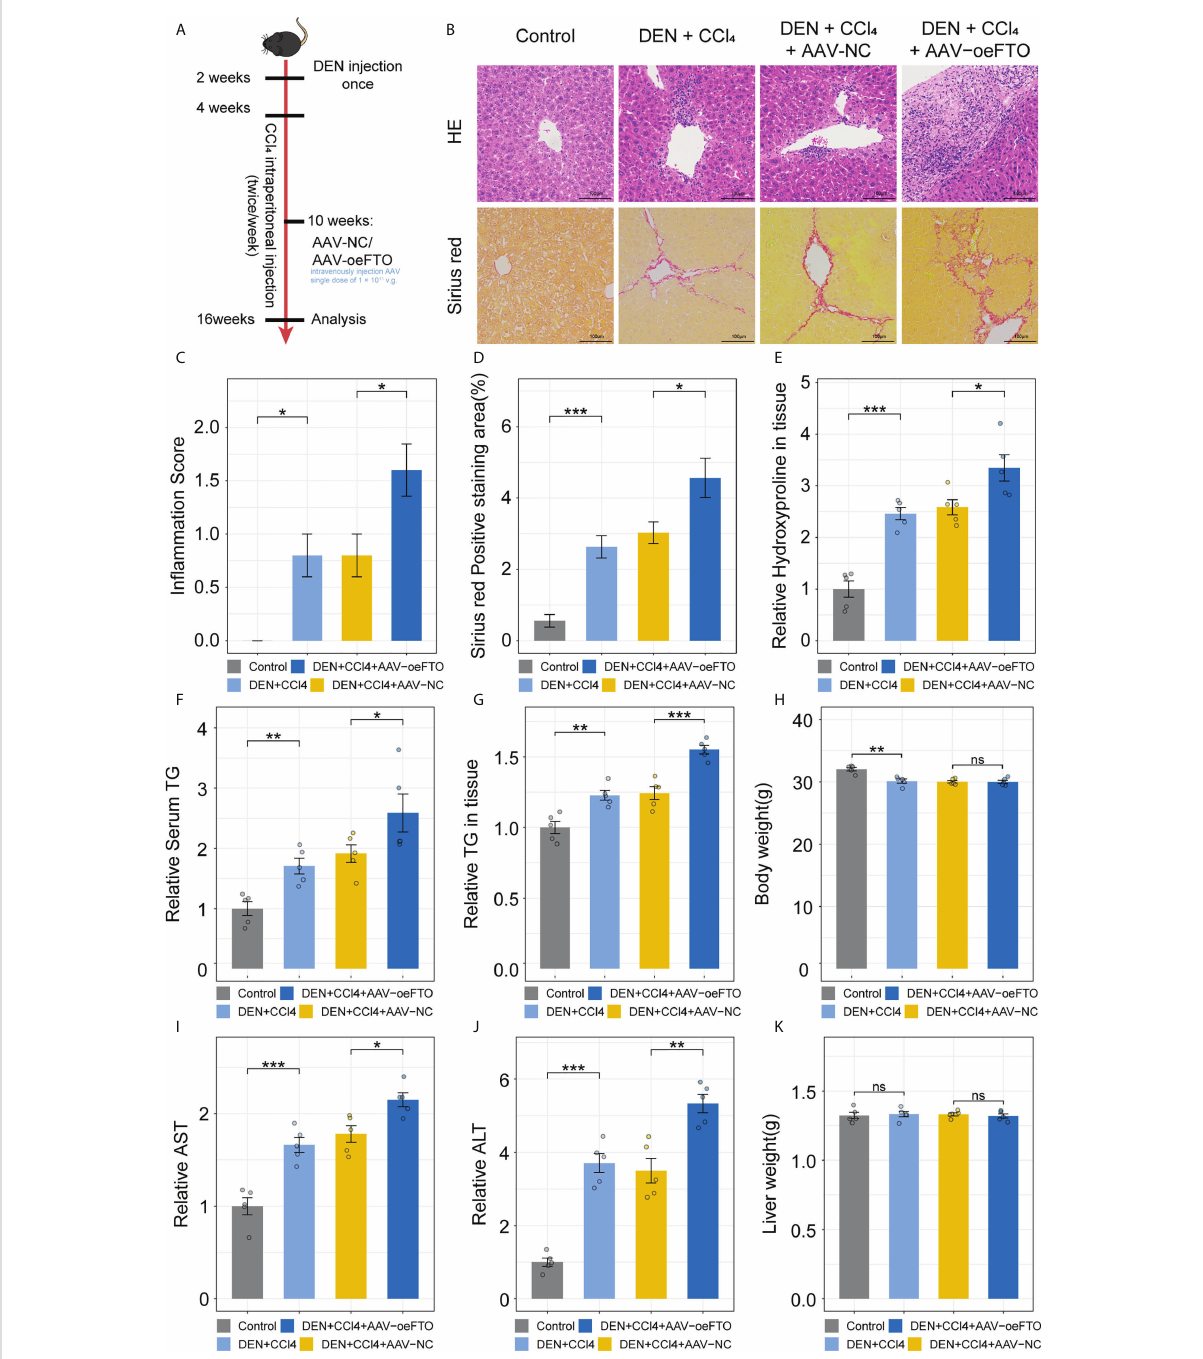
FIGURE 6 FTO promotes liver damage in murine chronic liver injury model. (A) Schematic of the in vivo experimental setup for construction of murine chronic liver injury model to ascertain FTO function. (B) Representative images of liver tissues staining for H&E and Sirius red in groups with different treatment by light microscopy. (C) In fl ammation score in all groups with different treatment. (D) Quantitative analysis of Sirius red positive area in all groups with different treatment. (E) Relative hydroxyproline level in liver tissues of all groups with different treatment. (F) Relative serum TG in all groups with different treatment. (G) Relative TG level in liver tissues of all groups with different treatment. (H) Body weight of mice in all groups with different treatment. (I, J) . Relative serum AST, and ALT in all groups with different treatment. (K) Liver weight of mice in all groups with different treatment. All experiments were repeated at least three times and expressed as the means ± SEM. n = 5; ns, not signi fi cant; * p < 0.05; ** p < 0.01; *** p <